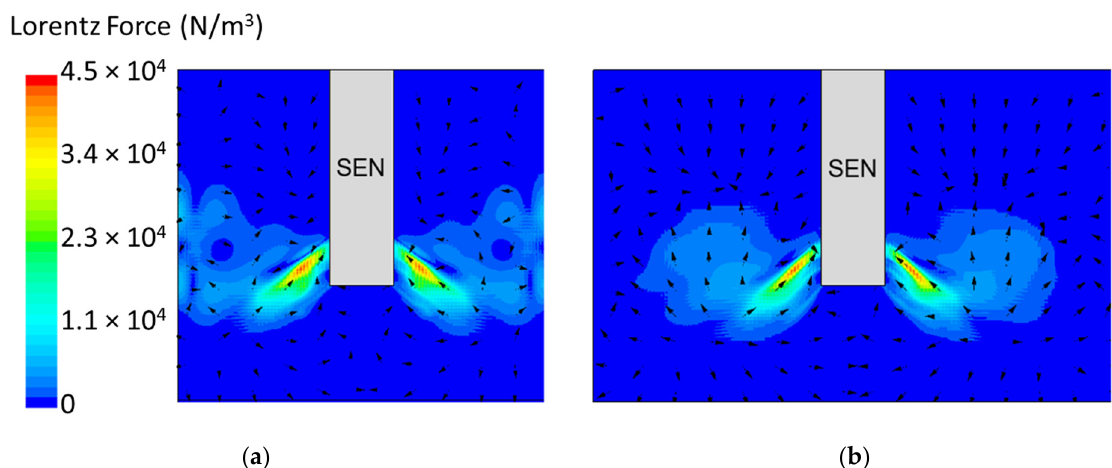
Figure 18. ( a ) Low mold width 1.067 m (Case 5) vs. ( b ) high mold width 1.50 m (Case 7) Lorentz force distribution.